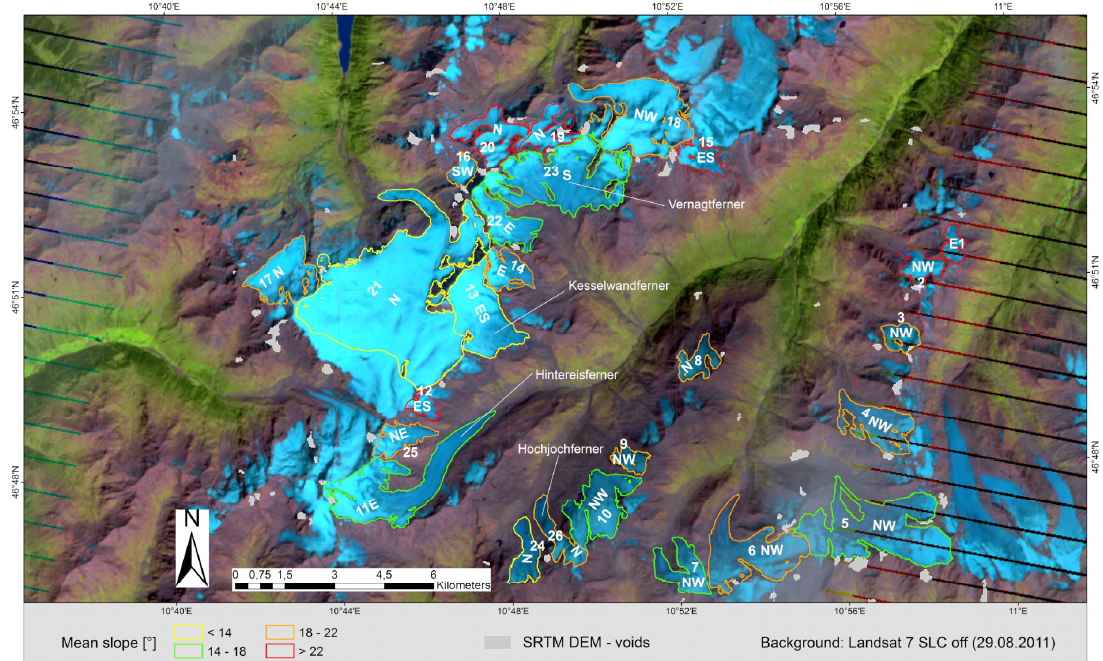
Figure 1. Study region Ötztal showing the 2011 Landsat 7 ETM + SLC-o ff satellite image (false colour composite: SWIR, NIR, red as RGB) used for deriving glacier extents. The outline colors indicate mean slopes (see legend for color), glacier numbers and mean aspect (cardinal sectors) are white. Stripes on the right hand side reveal the typically small impact of the scan line error on the glaciers. Landsat 7 ETM+ SLC-off scenes have thus also been used in the study region.